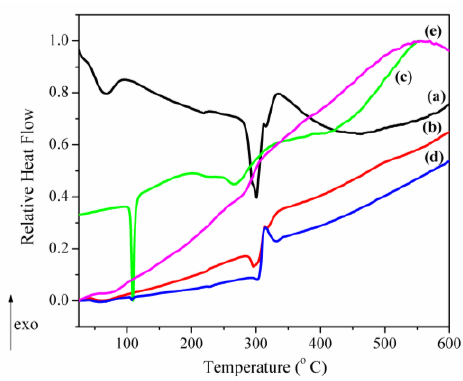
Figure 8. The relative heat flow DSC curves of ( a ) β -CD, ( b ) processed β -CD, ( c ) CAP, ( d ) the CAP- β -CD physical mixture and ( e ) the CAP- β -CD inclusion complex. physical mixture and ( e ) the CAP- β -CD inclusion